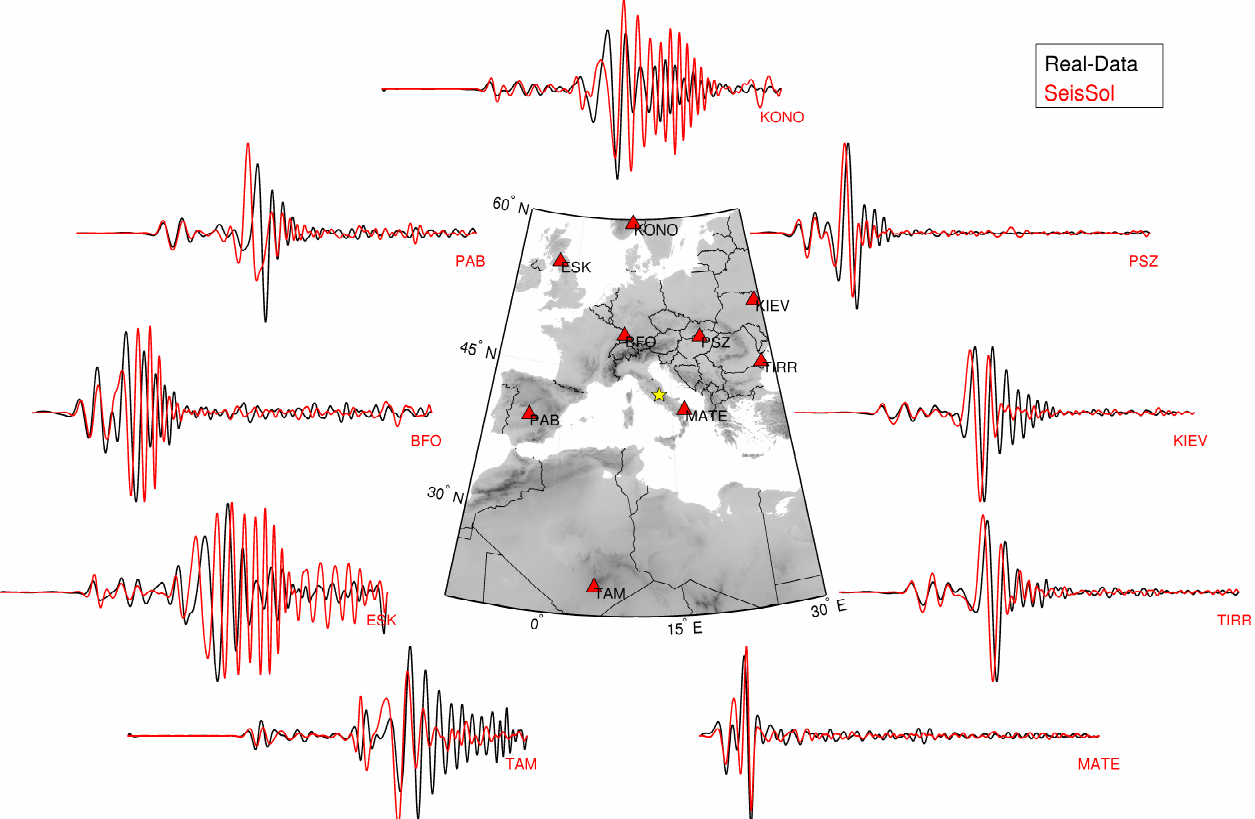
Fig. 7. Synthetic seismograms of the ADER-DG method obtained on the European model shown in Fig. 5 compared to real data of the 2009 L’Aquila earthquake (yellow star) at 9 different stations (red triangles). The vertical velocity component is shown for seismograms of 800s length, filtered to periods of T ≥ 33s.